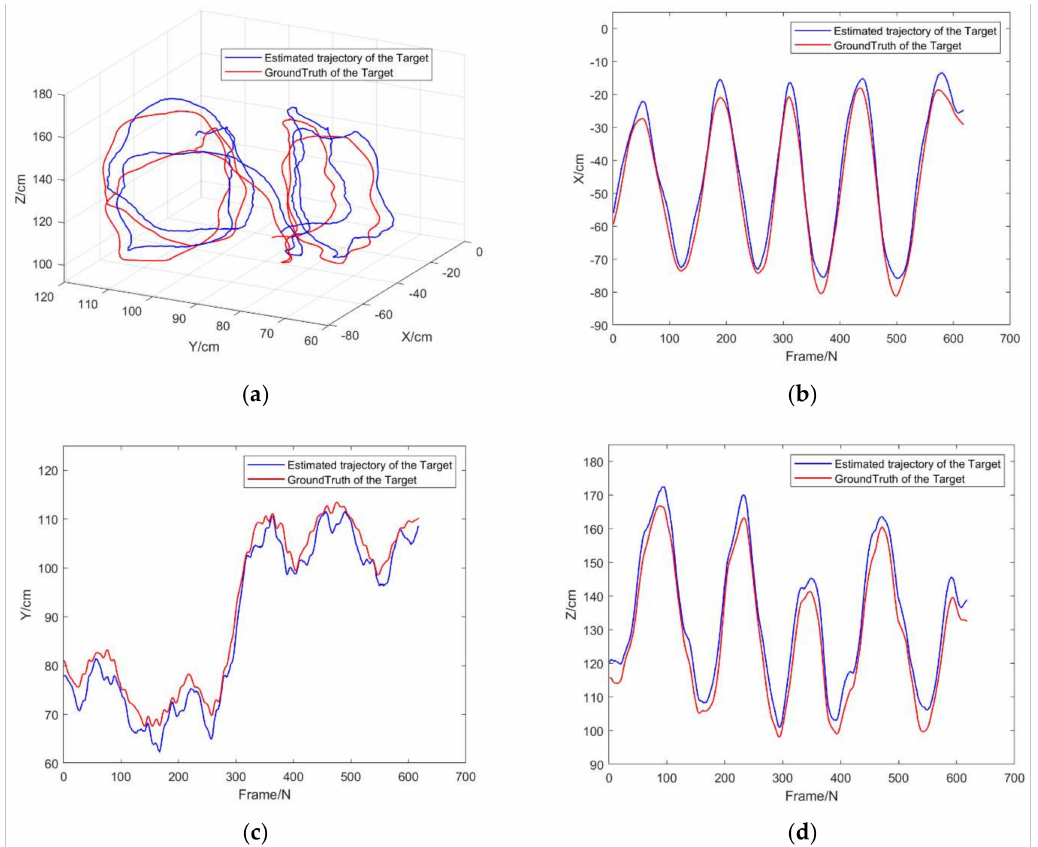
Figure 20. Results of the target tracking experiment: Red represents the ground truth of target measured by the motion capture system, and blue represents the target motion trajectory estimated by MLSS-VO and the target positioning algorithm based on geometric constraints: ( a ) comparison of three-dimensional trajectories; ( b ) comparison of x -axis; ( c ) comparison of y -axis; ( d )